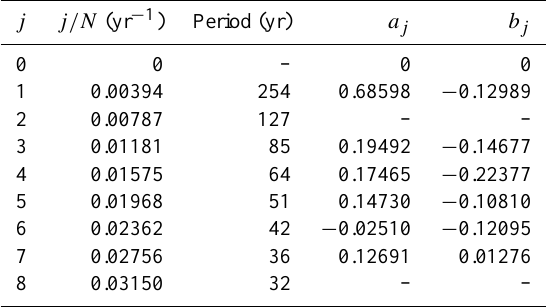
Table 1. Frequencies, periods, and the coefficients a j and b j of the reconstruction RM6 due to Eqs. (1), (3), and (4) ( N = 254).